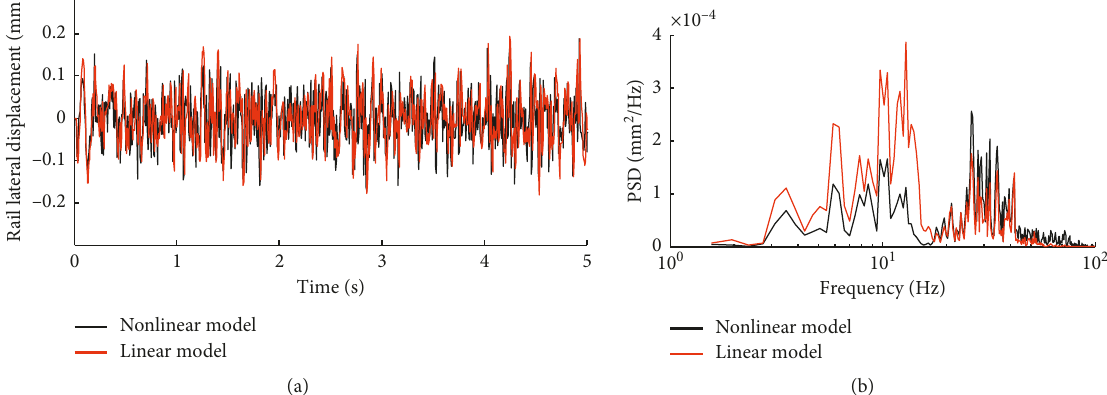
Figure 6: Comparison of rail lateral displacement between the linear model and the nonlinear model in the (a) time domain and (b) frequency domain.